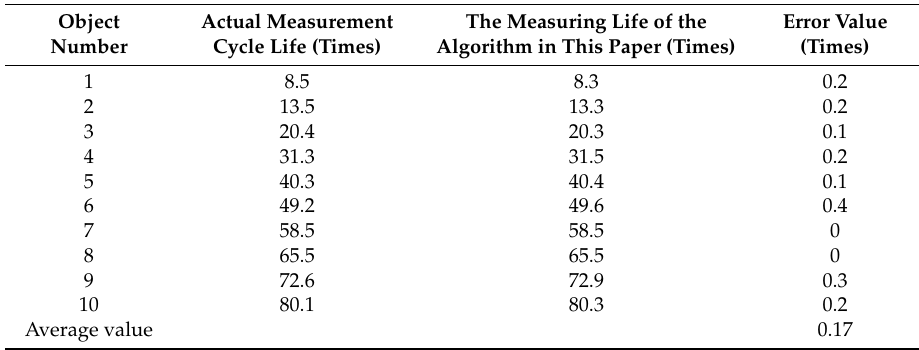
Table 7. The prediction results of the proposed algorithm.